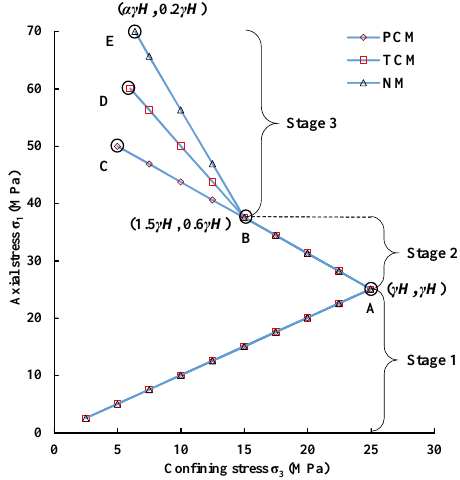
Figure 2. The stress unloading paths of different mining-induced stress conditions [39] .